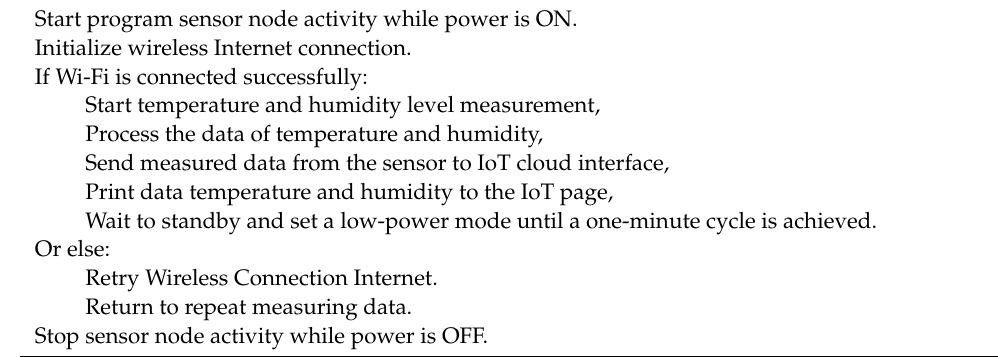
Algorithm 1. The logical flow of smart wireless climate sensor